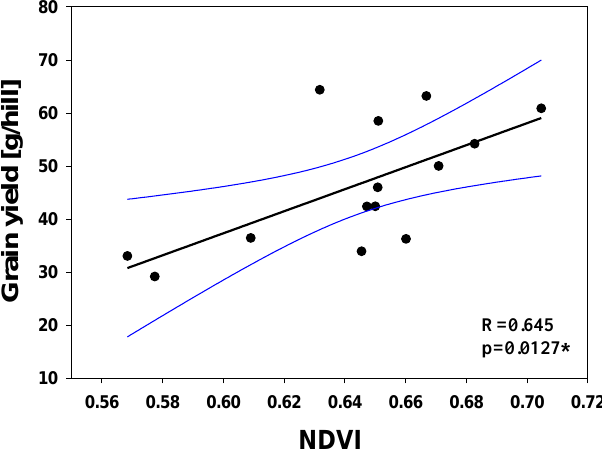
Figure 11. Correlation between the NDVI and grain yield. The blue line refers to the 95% confidential interval. R and p refer to the Pearson correlation coefficient and p -value, respectively (* p < 0.05; ** p < 0.01; *** p < 0.001).